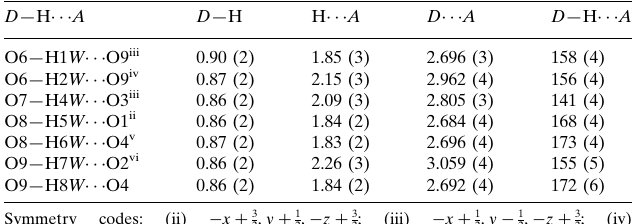
Hydrogen-bond geometry (A˚ , (cid:3)